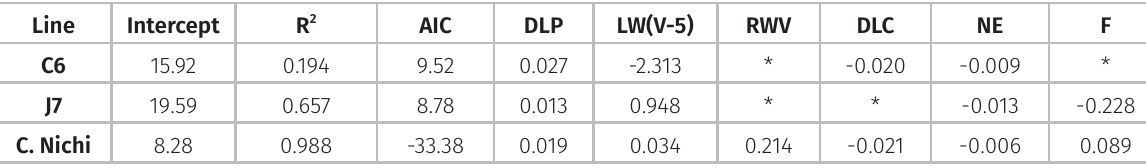
Table V. Intercept and coefficients of the Lasso regression model by line. *Variable not selected. AIC: Akaike information criterion, DLP: duration of the larval period, DLC: duration of the life cycle, LW(V-5): larval weight of the fifth day of the fifth instar, RWV: rate of weight gain of the fifth instar, NE: number of eggs, F: